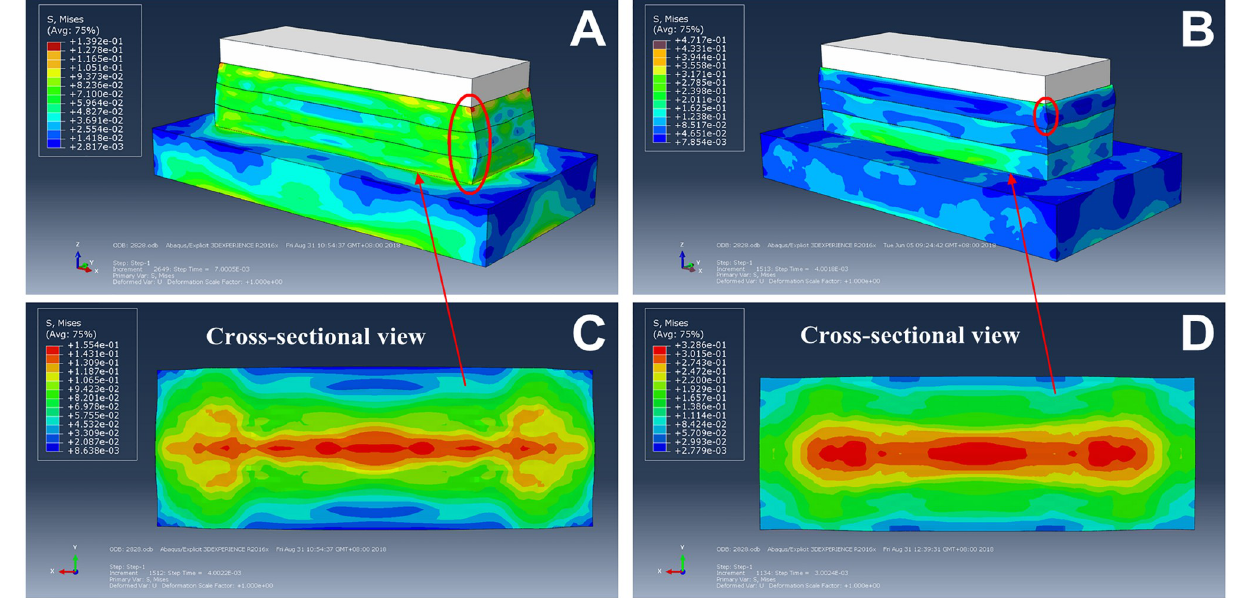
Fig 5. Qualitative comparisons of stress distributions and deformations between the bio-inspired feet on loose sand. Deformations and stress distributions of the 15-15-15 HA bio-inspired foot (A, C, respectively) and 15-35-55 HA bio-inspired foot (B, D, respectively).